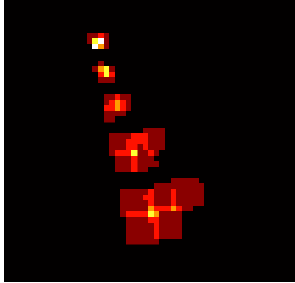
Figure 15. Regions R t where abundances contribute to the estimation of the area for each target t . Brightest pixels indicate that an image element is considered for several targets, i.e., it may have a higher degree of mixture. Pixels where contributions from a single material are expected are represented in dark red, while pixels where five materials can contribute, as in the smallest targets to the north, are depicted in